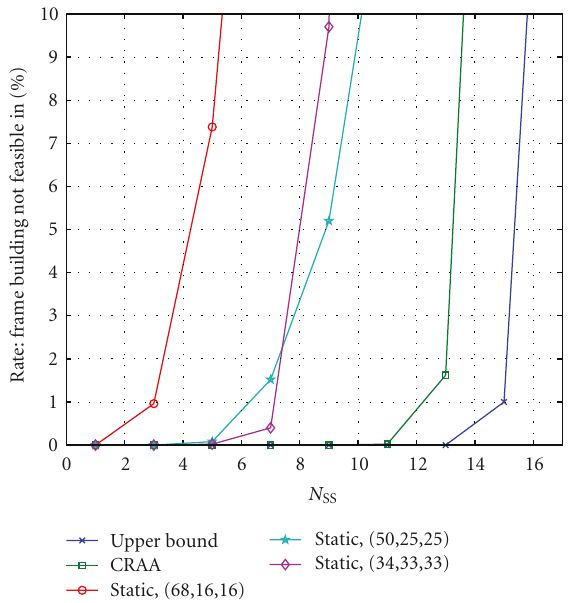
Figure 6: Rate of how often the frame building fails related to the total number of simulated frames for the di ff erent algorithms depending on the number of SSs. The minimum data rate is 2560 bits per